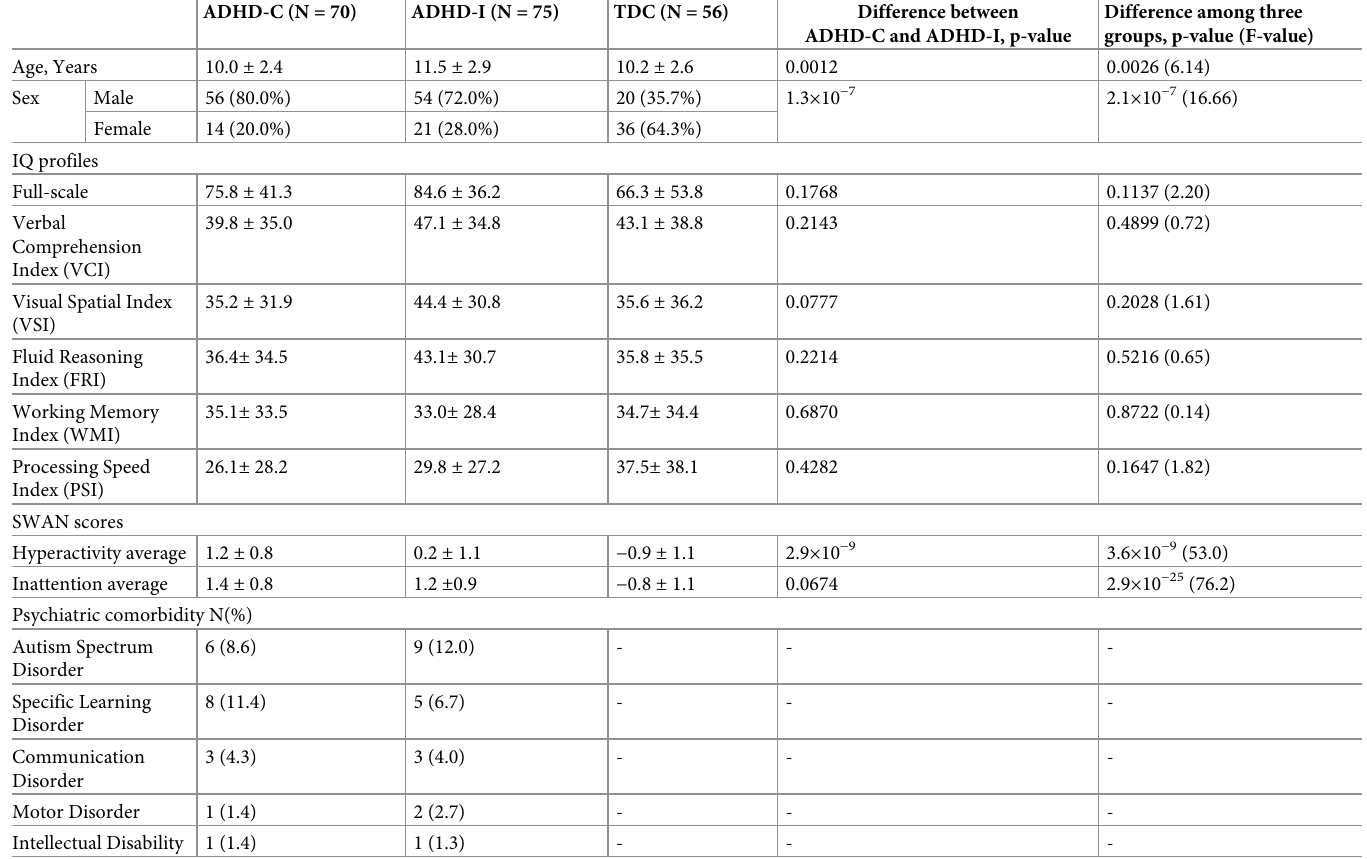
Table 1. Demographics and clinical characteristics of ADHD and typically developing children.